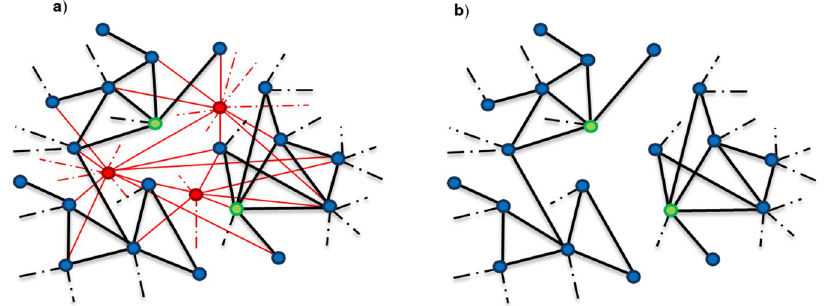
Figure 6. Removing hubs decreases noise and make the graph sparser. The red nodes in the figure ( a ) denote inter-module hubs and the green nodes denote module hubs in the network. When we remove inter-module hubs from the network, we will eliminate some noise and will have sparser and well-separated graph ( b ).